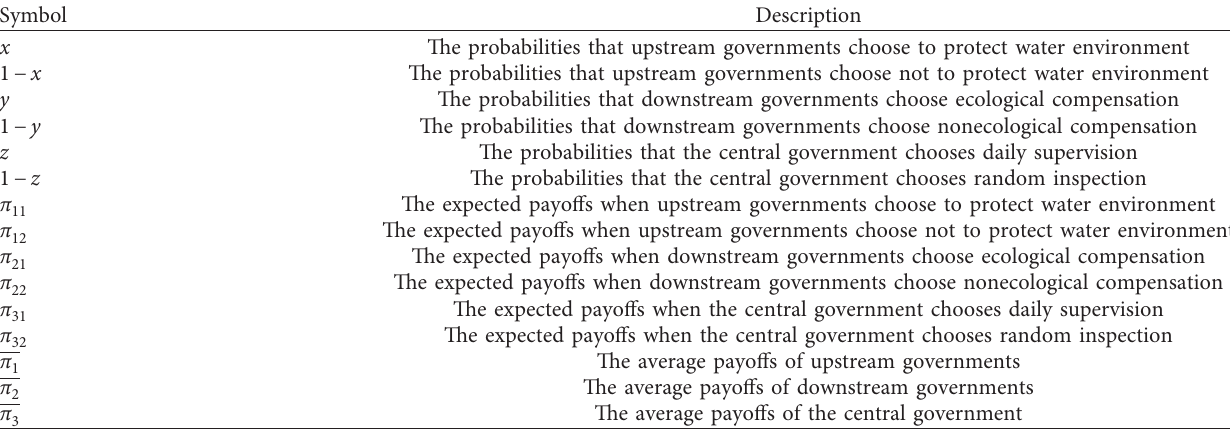
Table 4: The description of different